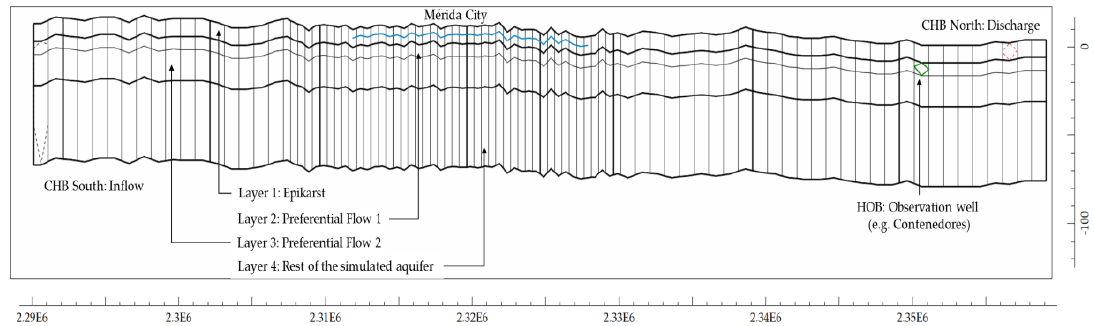
Figure 2. Discretization of the study area, view from South to North. The X axis represents Universal Transverse Mercator coordinates (UTM) and Y axis depth in meters.